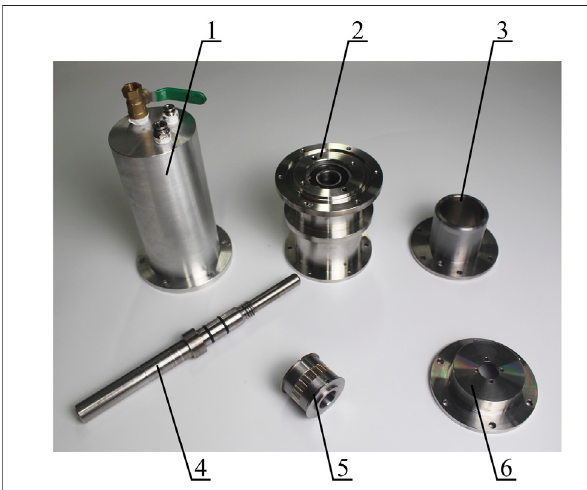
FIGURE 6 | Test bench for MFSs (1-computer, 2-power supply, 3-data acquisition card, 4-pressure sensor, 5-air compressor, 6-regulator valve, 7- sealing prototype, and 8-ball